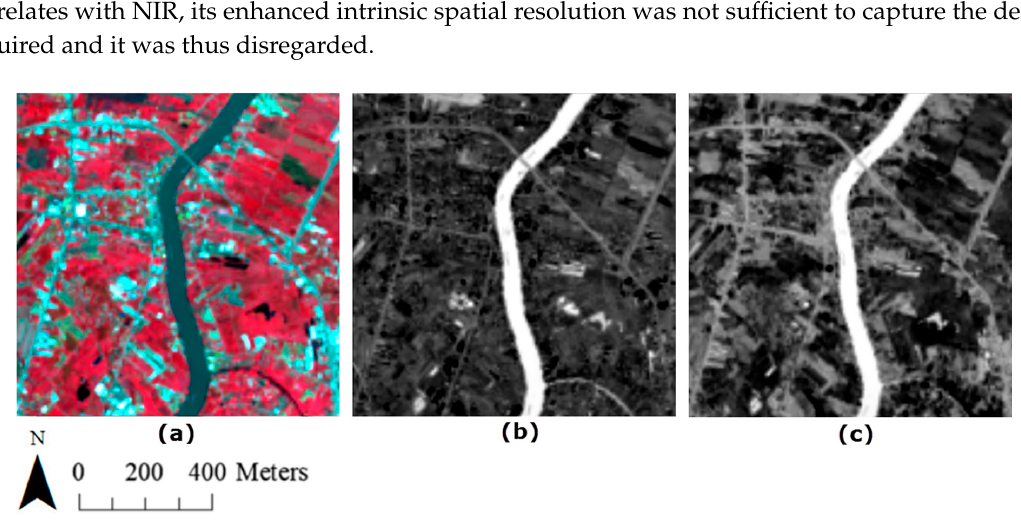
Figure 2. ( a ) Landsat 8 images interpolated at five-meter spatial resolution; and corresponding water index images: ( b ) MNDWI (Modified Normalized Difference Water Index); and ( c ) NDWI2 (Normalized Difference Water Index 2), of an area sampled in 2015.